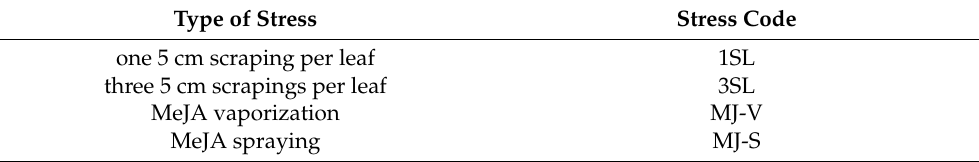
Table 1. Artificial stress codes used to identify the volatile samples